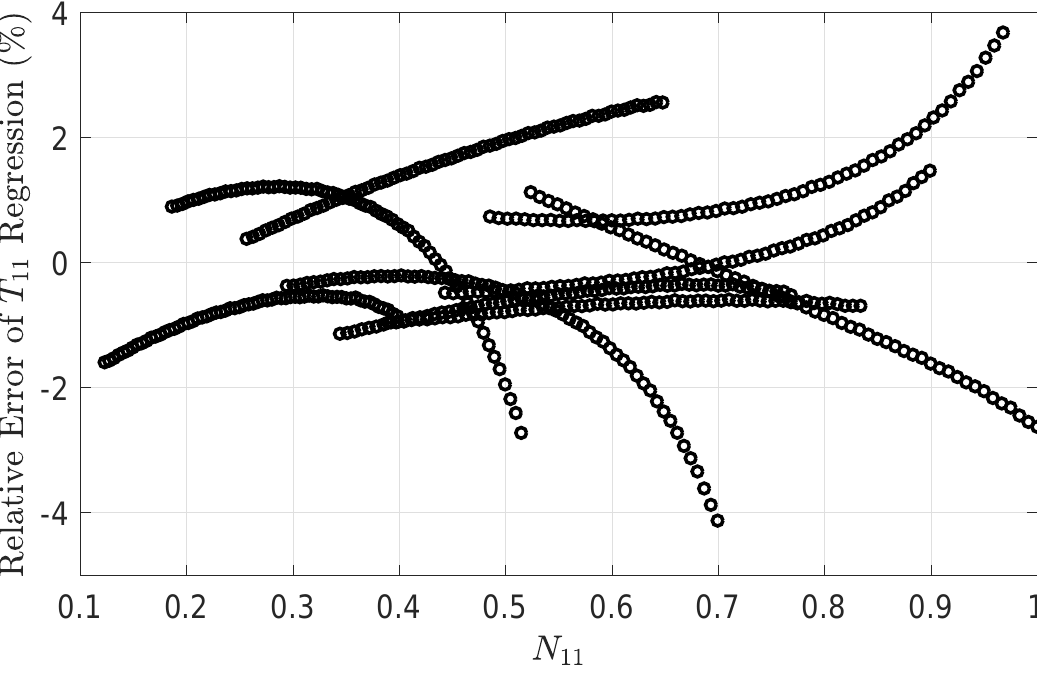
Figure 6. Relative error of T 11 regression